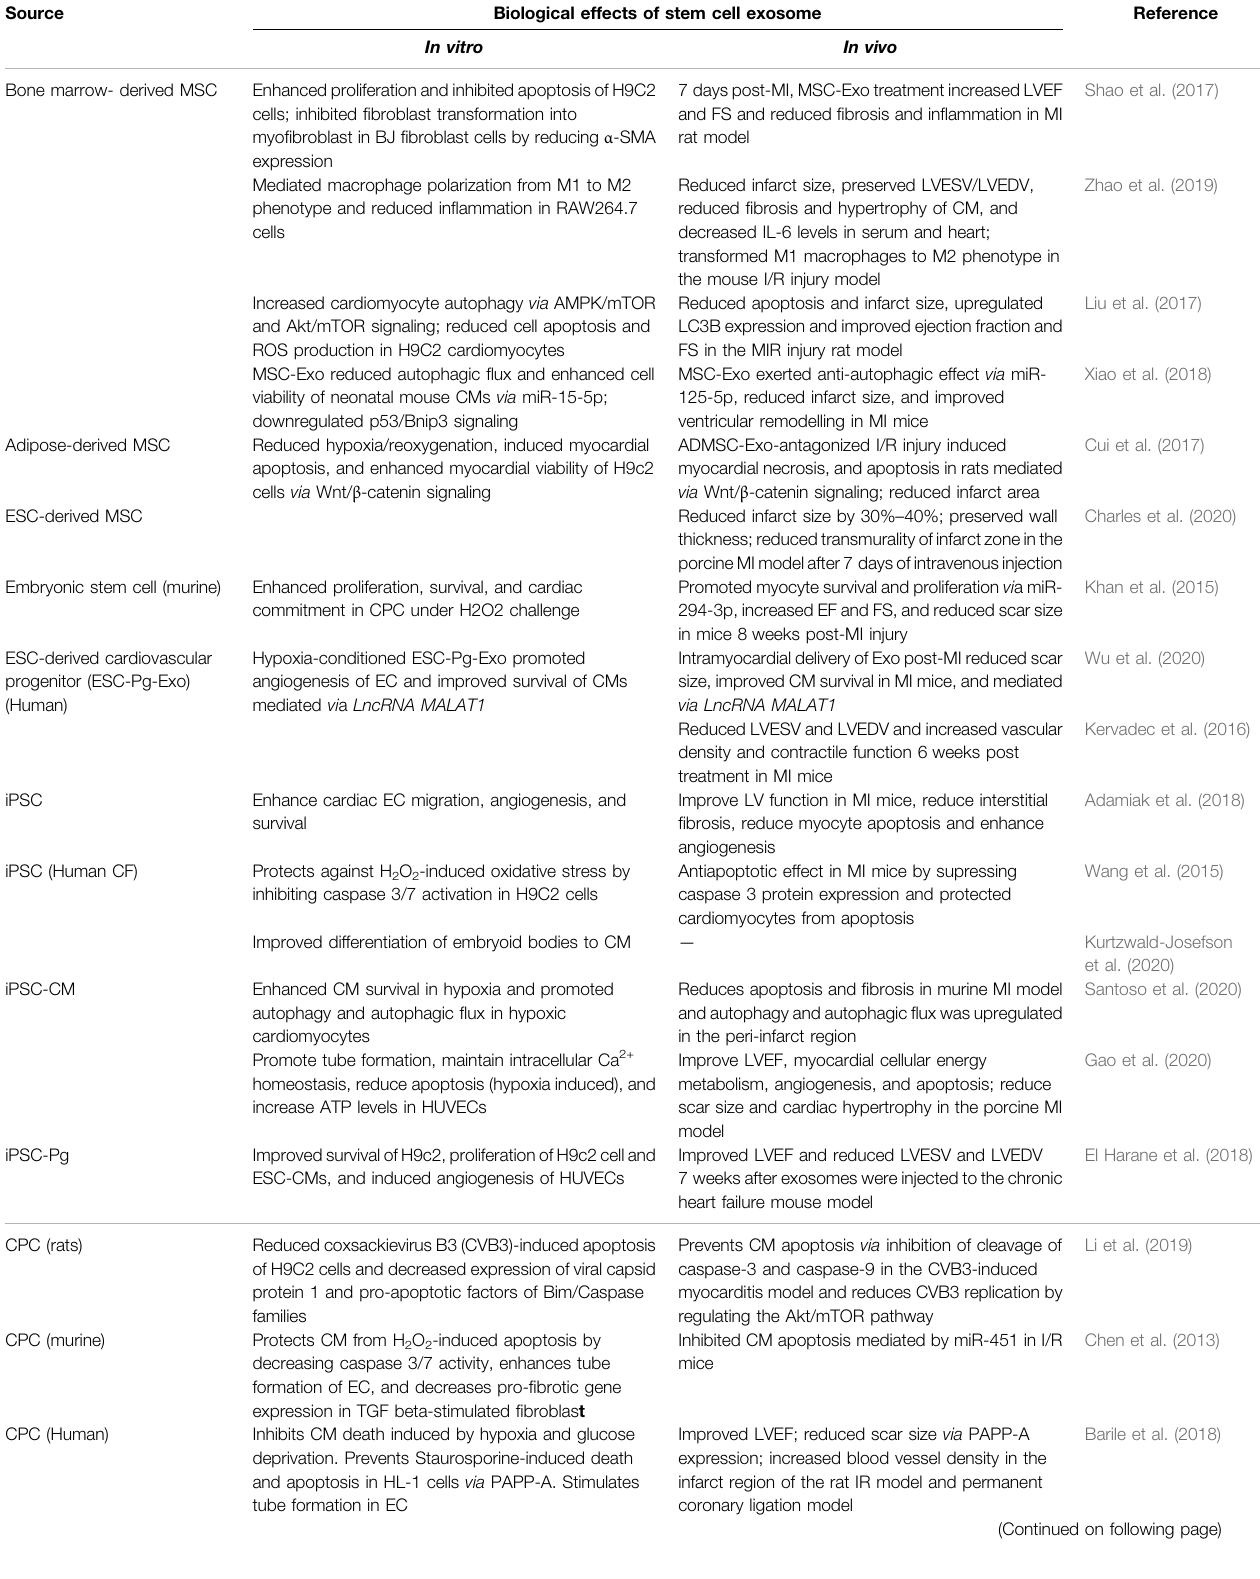
Table1| Cardioprotectivemechanismsofstemcellexosomes. Asummaryofvariousmechanismsinvolvingstemcellexosomesincardiacrepairidenti fi edusing invitro and in vivo models.